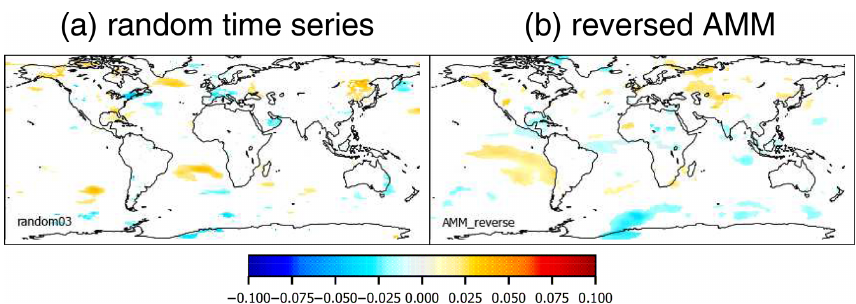
Figure 6. Global maps of the fit results for an artificial time series containing only white noise (a) and a temporally reversed teleconnection index (AMM, b ). The white areas represent fit results, which are classified as non-significant by the fit routine (for a 5% significance